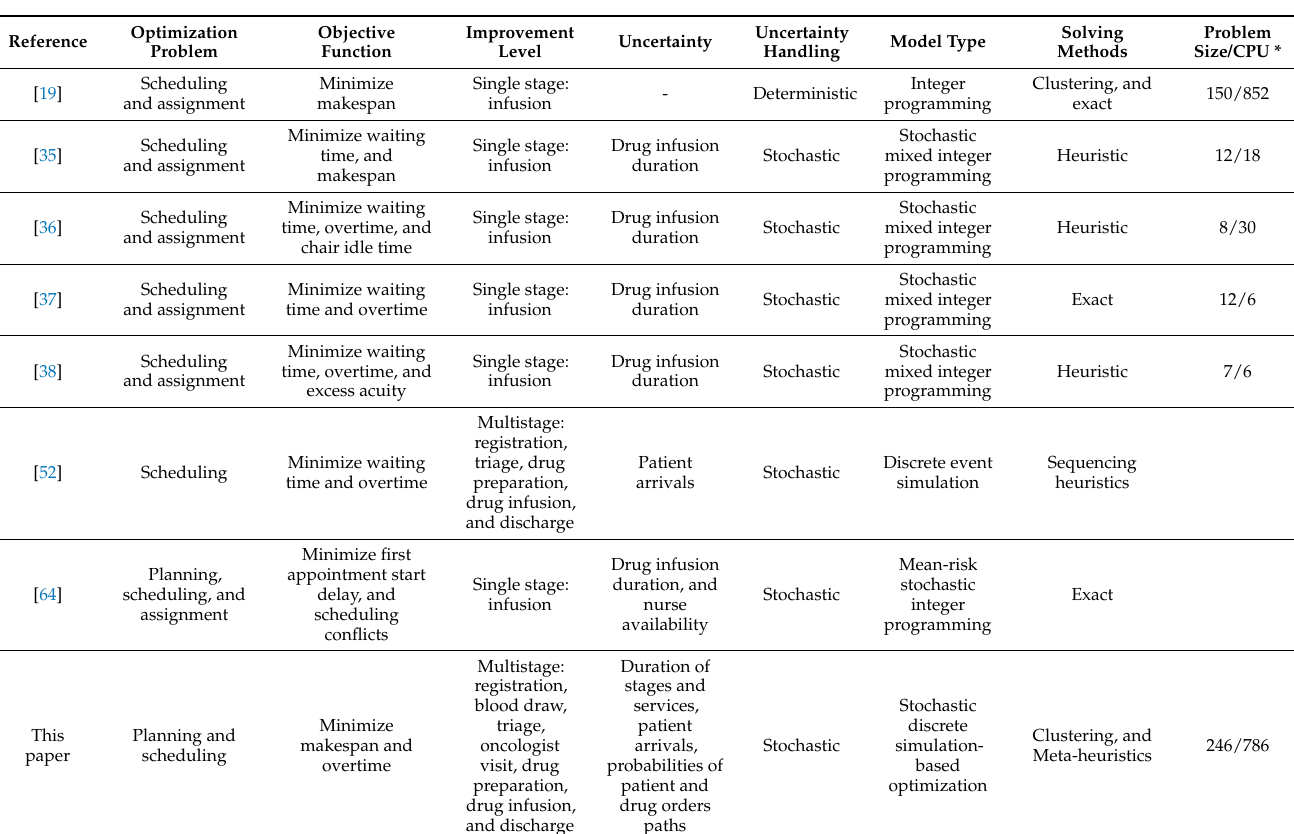
Table 2. Previous relevant OCA